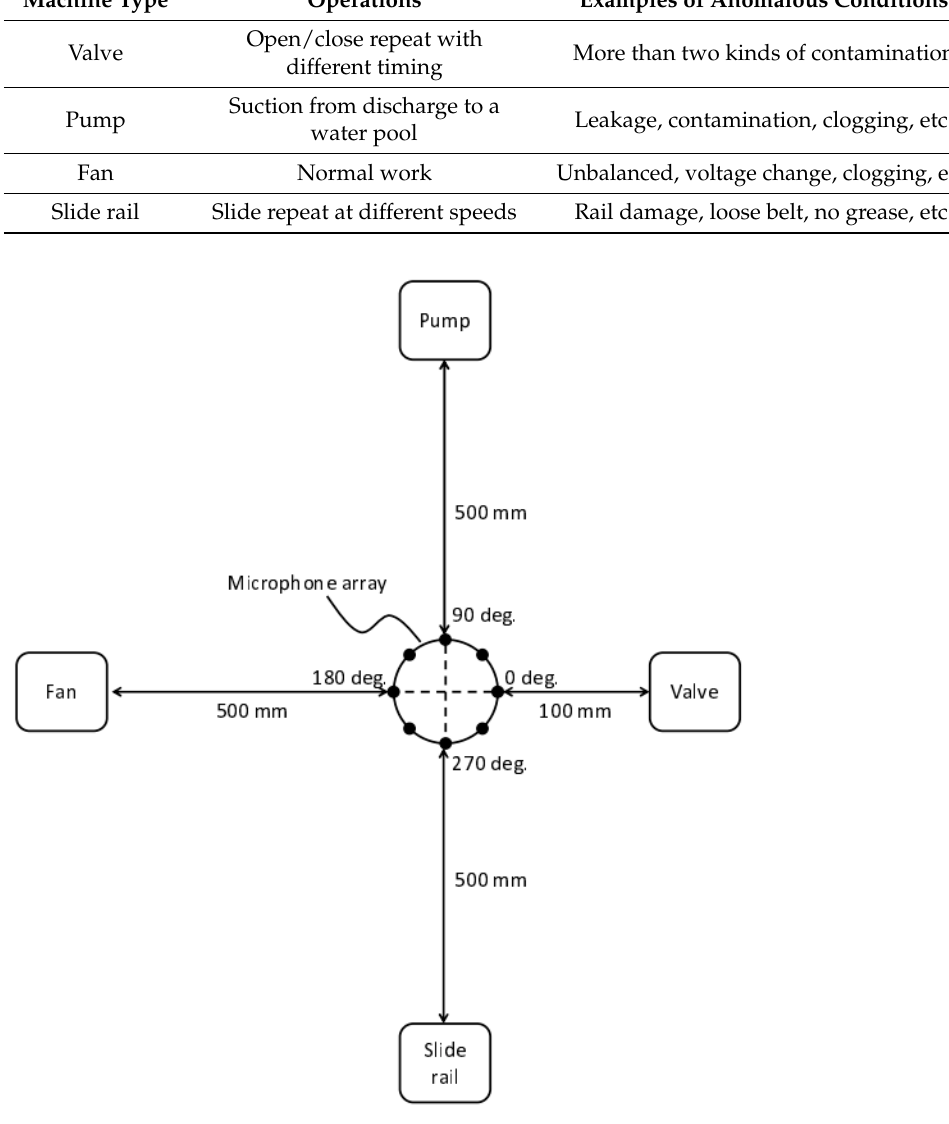
Figure 13. Schematic of microphone installation setup for MIMII [10].